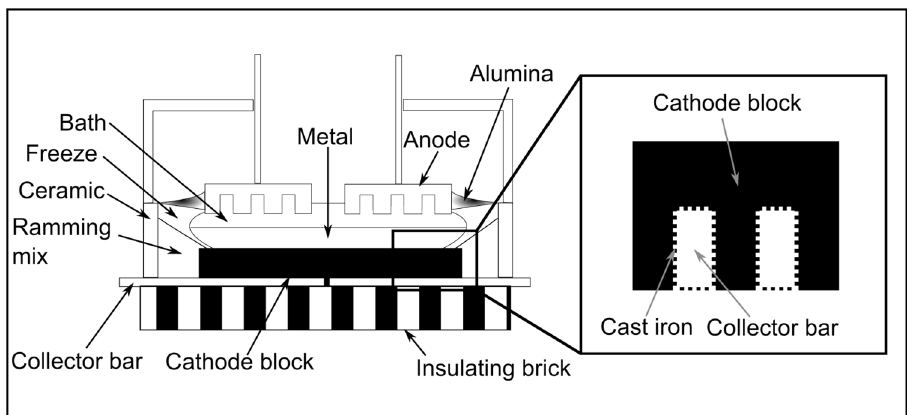
Fig. 1 Schematic drawing of an aluminum electrolysis cell. In the right the expanded cath- ode is rotated by 90 ° to show the compound of cast iron and collector bar